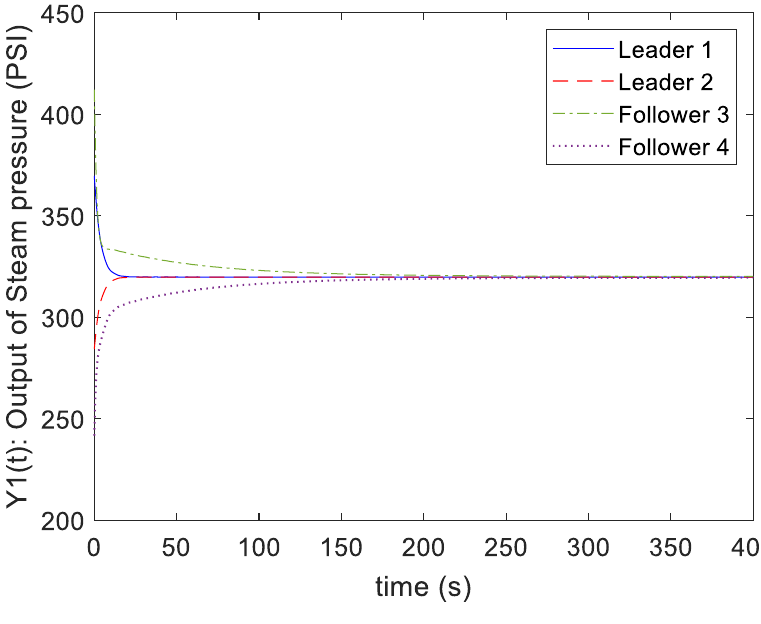
Figure 14. Responses of output Y 1 ( t ) with type-1 fuzzy control.